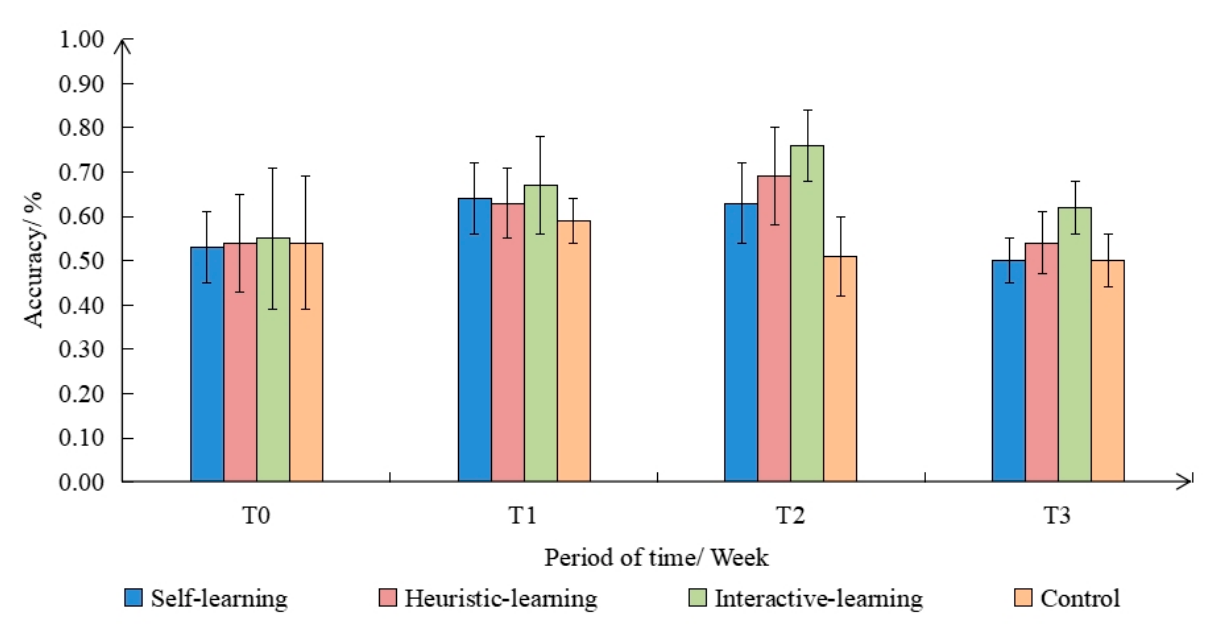
Figure 4. Changes in the accuracy of different groups and time periods.